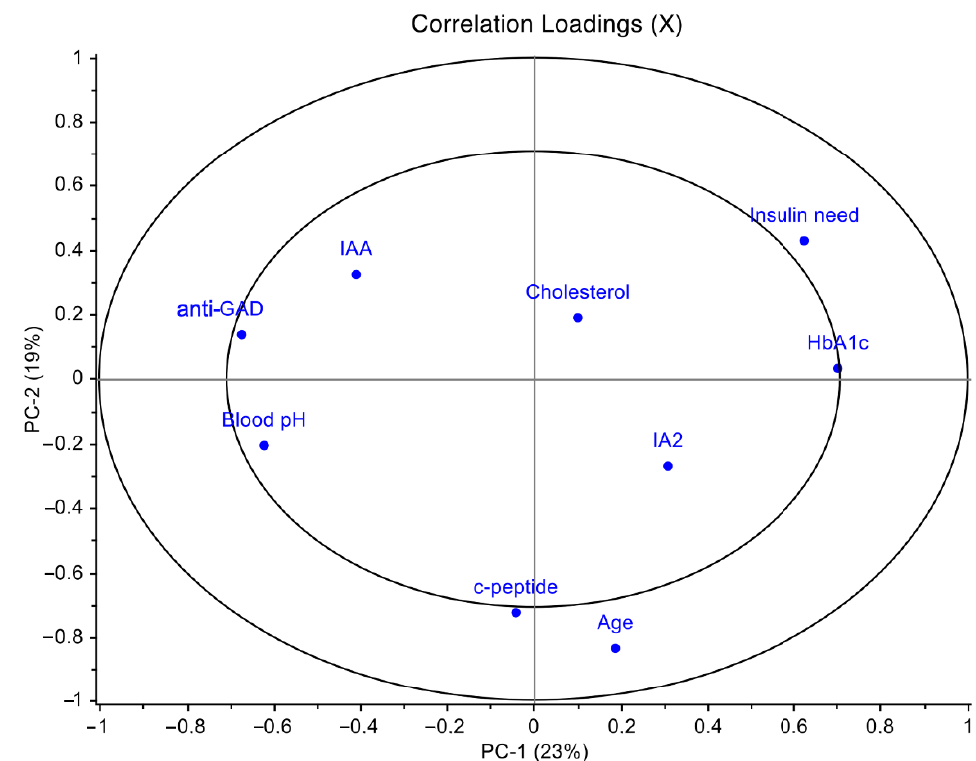
Figure 1. Principal component analysis (PCA) loadings plot of T1D clinical data performed on the T1D overall cohort. PCA was applied to the entire matrix of variables composed of anti-GAD, IAA, IA2, HbA 1c , cholesterol, exogenous insulin need, blood pH, age and c-peptide, after autoscaling. These variables were selected among all the clinical parameters for T1D in order to avoid information redundancy. PCA model showed the first principal component (PC1) accounted for 23% of the overall variance and the second principal component (PC2) accounted for 19%.